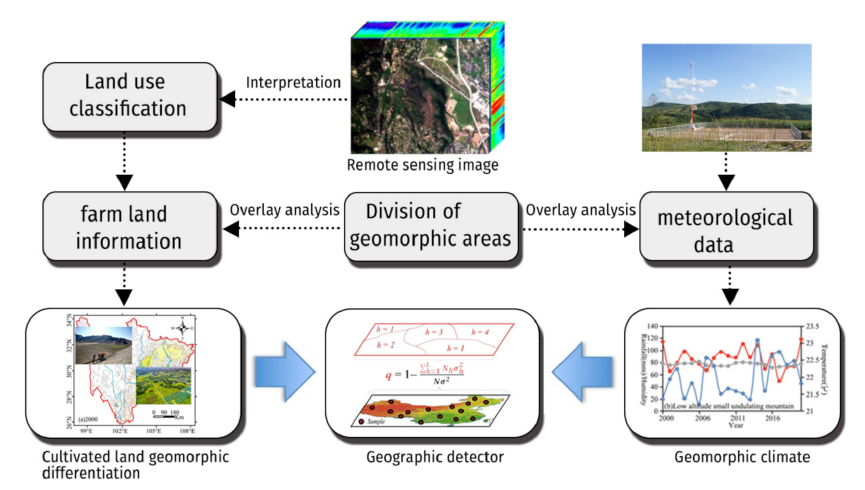
Figure 2. Research